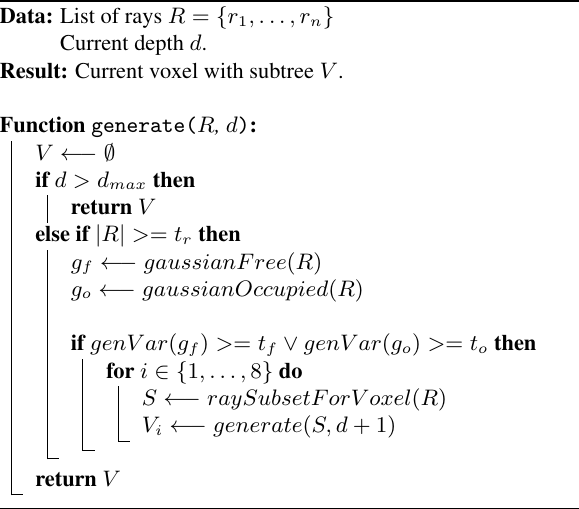
Algorithm 1: Generation of the Gaussian Occupancy Octree. Data: List of rays R = { r 1 , . . . , r n } Current depth d .